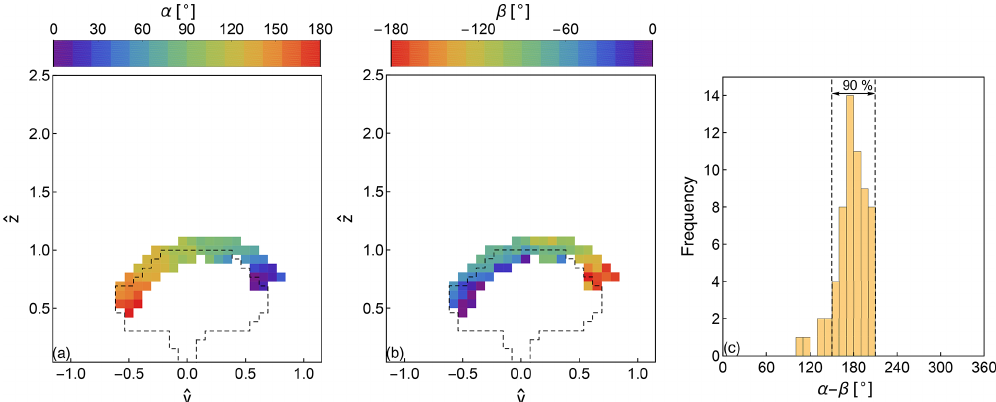
(cid:104)ˆ u 1 (cid:105) ∂ ˆ x i